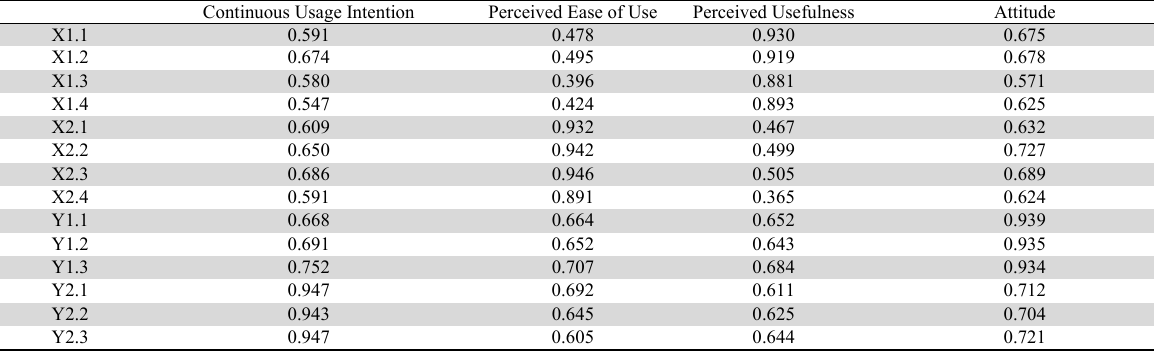
Discriminant Validity Test Results Using Cross Loading Continuous Usage Intention